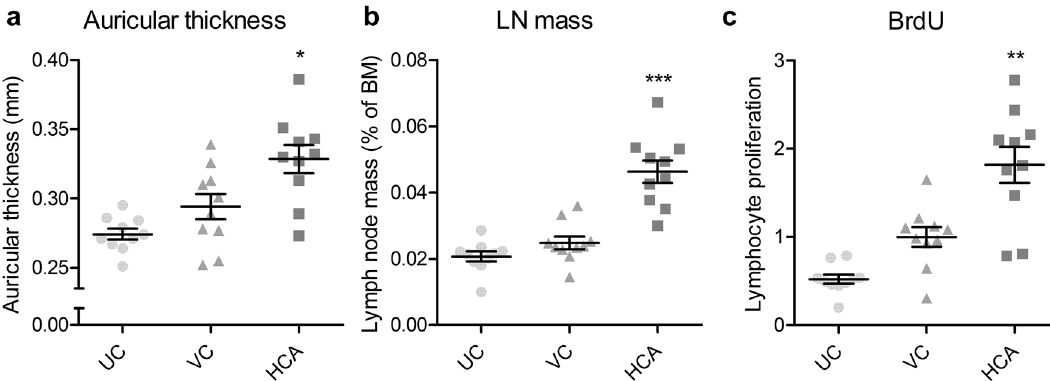
Figure 7. Changes in the auricle and auricular lymph nodes of mice treated with HCA, once daily for 3 days, according to OECD test guideline 442B. Left auricular thickness ( a ), auricular lymph node-to-body mass ratio ( b ), and BrdU-labeled lymphocyte proliferation in the lymph nodes ( c , ratio to vehicle control) were measured in the untreated (UC) and vehicle-only (VC) or DNFB-treated mice, 3 days after the final treatment. The graphs are scatter plots, where each symbol represents an actual measurement, and the centerlines and error bars represent the mean and standard error, respectively. Asterisks indicate levels of significant differences from the vehicle control: * P < 0.05, ** P < 0.01, *** P <